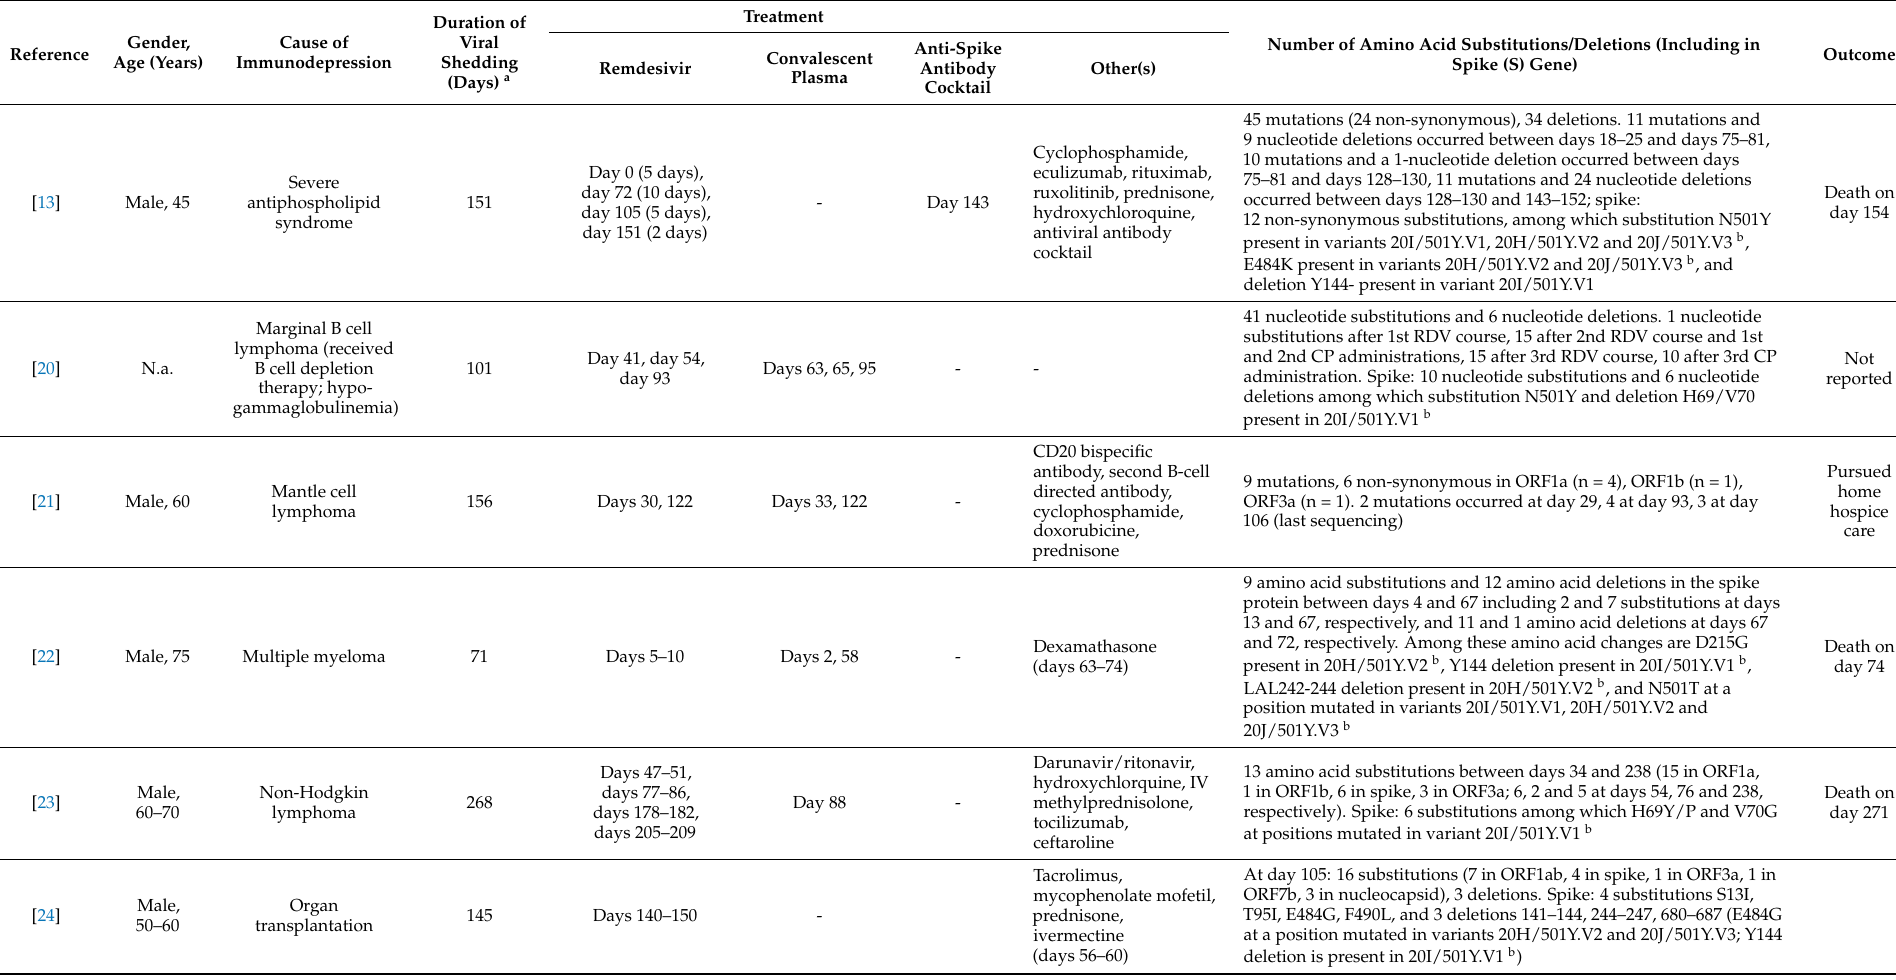
Table 1. Epidemiological, virological, and clinical features of cases of prolonged SARS-CoV-2 infections in immunocompromised patients who received